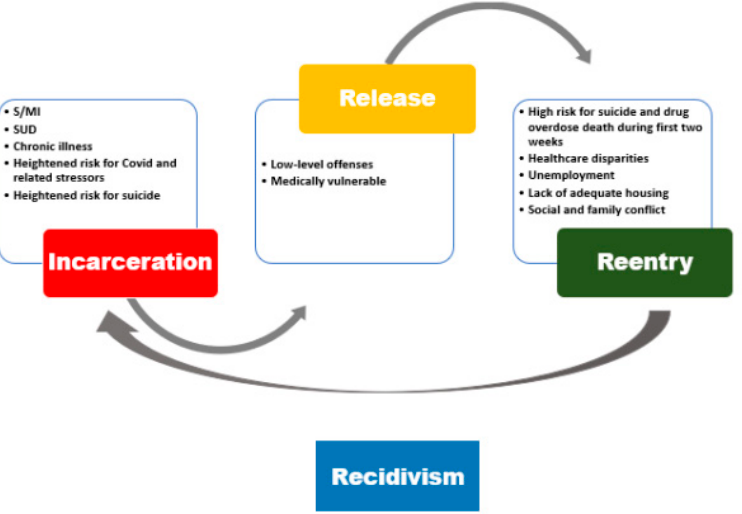
Figure 5. The fatal feedback loop, as represented in Intersection #3: COVID-19, mental illness, and incarceration.